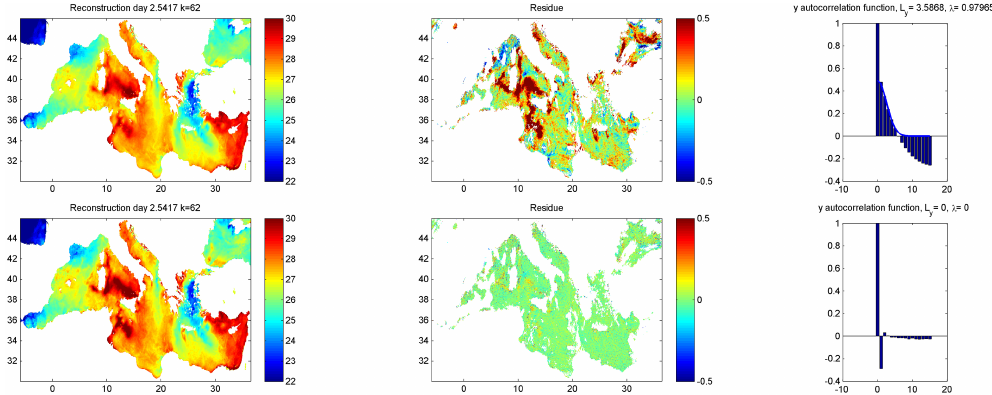
Figure 5. DINEOF reconstruction, residual and autocorrelation of residuals. DINEOF (top) and new method DINEOFOI (lower images).